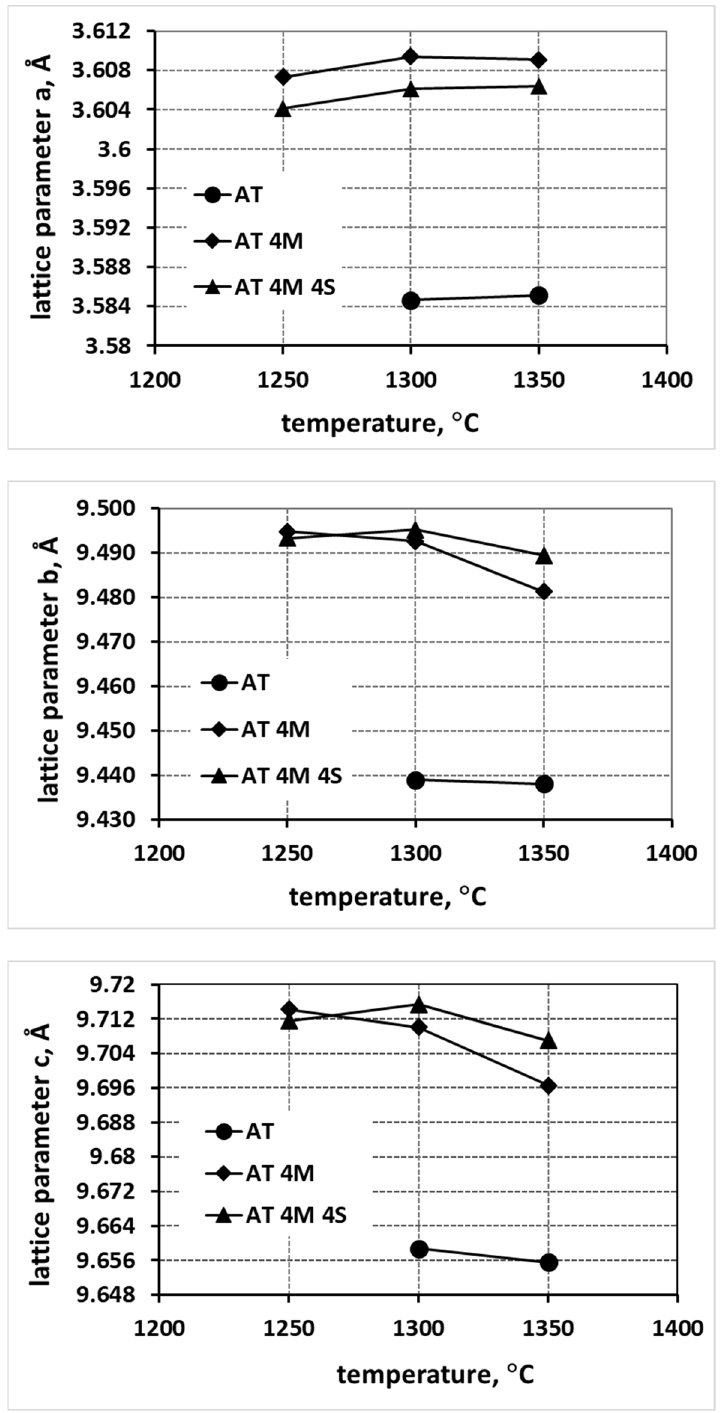
Figure 2. Changes in lattice parameters of tialite elementary cell and its solid solutions in systems stabilized by MgO (AT 4M) and MgO with nanosilica (AT 4M 4S) compared with tialite without stabilizers (AT).